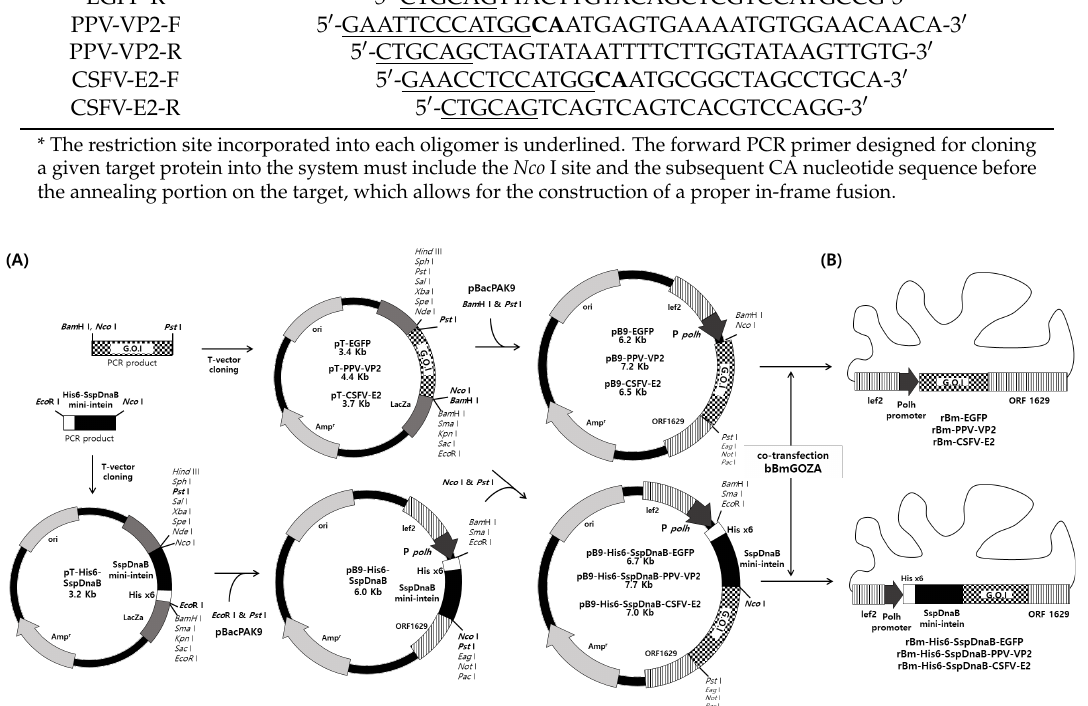
Figure 1. ( A ) Construction of the transfer vectors ( B ) and a schematic representation of recombinant viruses. PCR amplification of each of the DNA fragments that were cloned into the T-vector; the PCR products were sequentially cloned into the transfer vector pBacPAK9. Finally, each constructed transfer vector was co-transfected into Bm5 cells with bBmGOZA to generate each recombinant